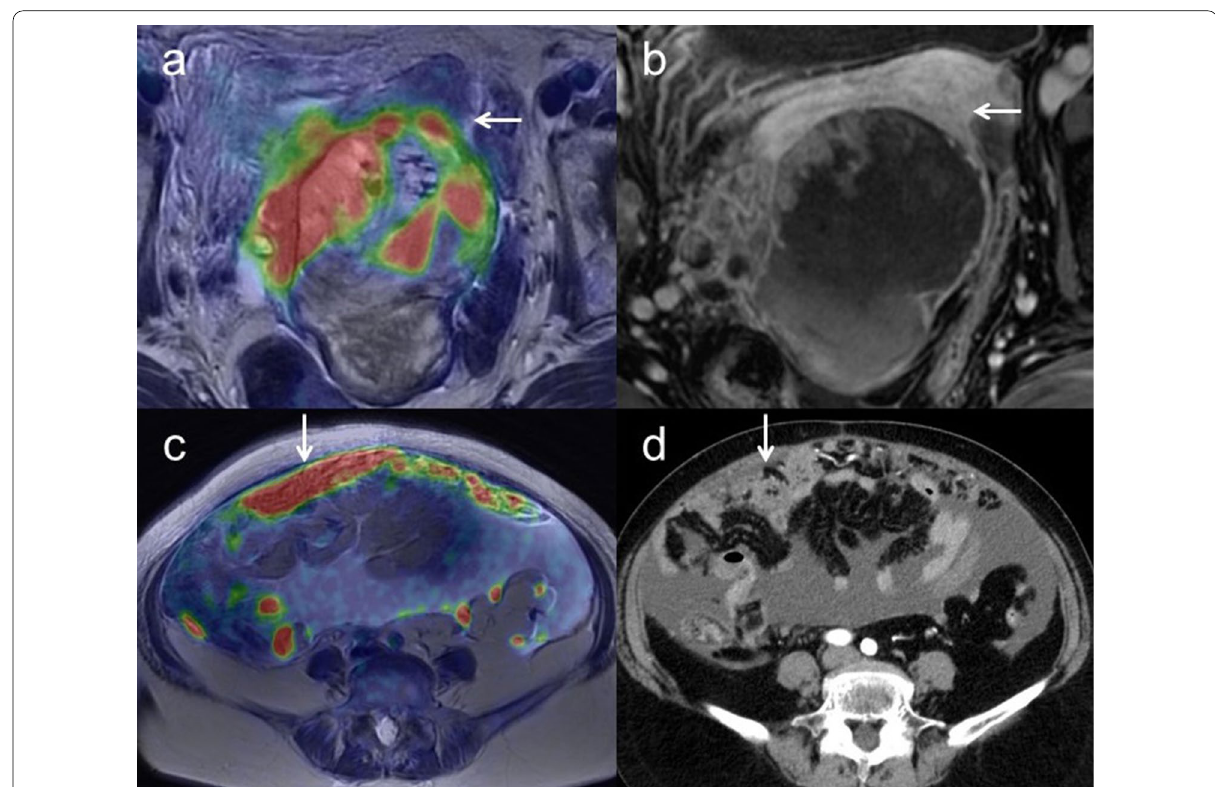
Fig. 2 a A 67-year-old woman with right ovarian tumor. Axial T2-weighted PET/MR image shows a papillary solid part with FDG uptake invading the posterior uterine myometrium (arrow) in a polycystic right ovarian tumor. b Axial T1-weighted contrast-enhanced MR image shows the papillary solid part with good enhancement (arrow) and unclear findings of growth into the uterus. Histopathologic examination confirmed carcinosarcoma with growth into the posterior uterine myometrium (T2a). c A 62-year-old woman with suspected ovarian cancer. Axial T2-weighted PET/MR image shows the omental cake with FDG uptake (arrow). d Contrast-enhanced CT shows thickening of the omentum with good enhancement (arrow). These findings strongly suggest potential malignancy with carcinomatous peritonitis and histopathologic examination confirmed high-grade serous carcinoma with carcinomatous peritonitis (T3c)